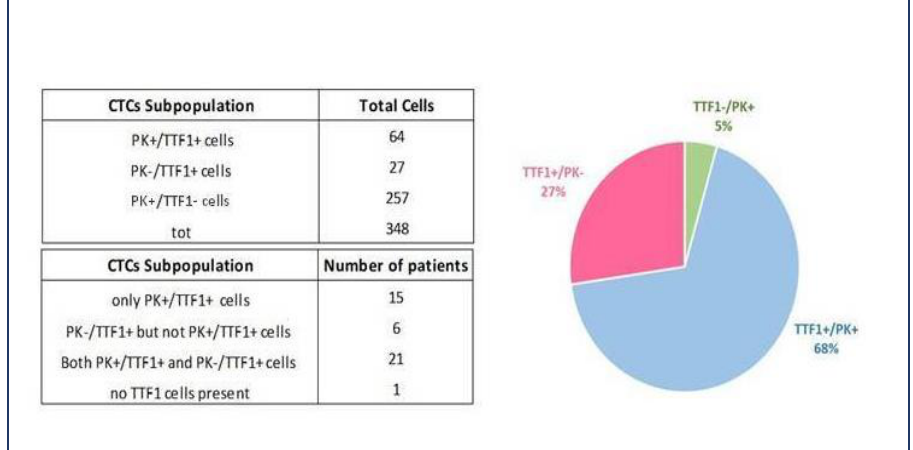
Figure 5. NSCLC patients tested for TTF-1 expression on liquid biopsy. The ability to detect TTF-1 expression of both PK-/CD45- and PK+/CD45-circulating cells on the SBS ® slide allows for increased prognostic power in identifying TTF-1+ patient samples irrespective of cytokeratin expression and demonstrates epithelial plasticity. NSCLC, non-small cell lung cancer; TTF-1, thyroid transcription factor-1; PK, pan-cytokeratin; CTCs, circulating tumor cells.